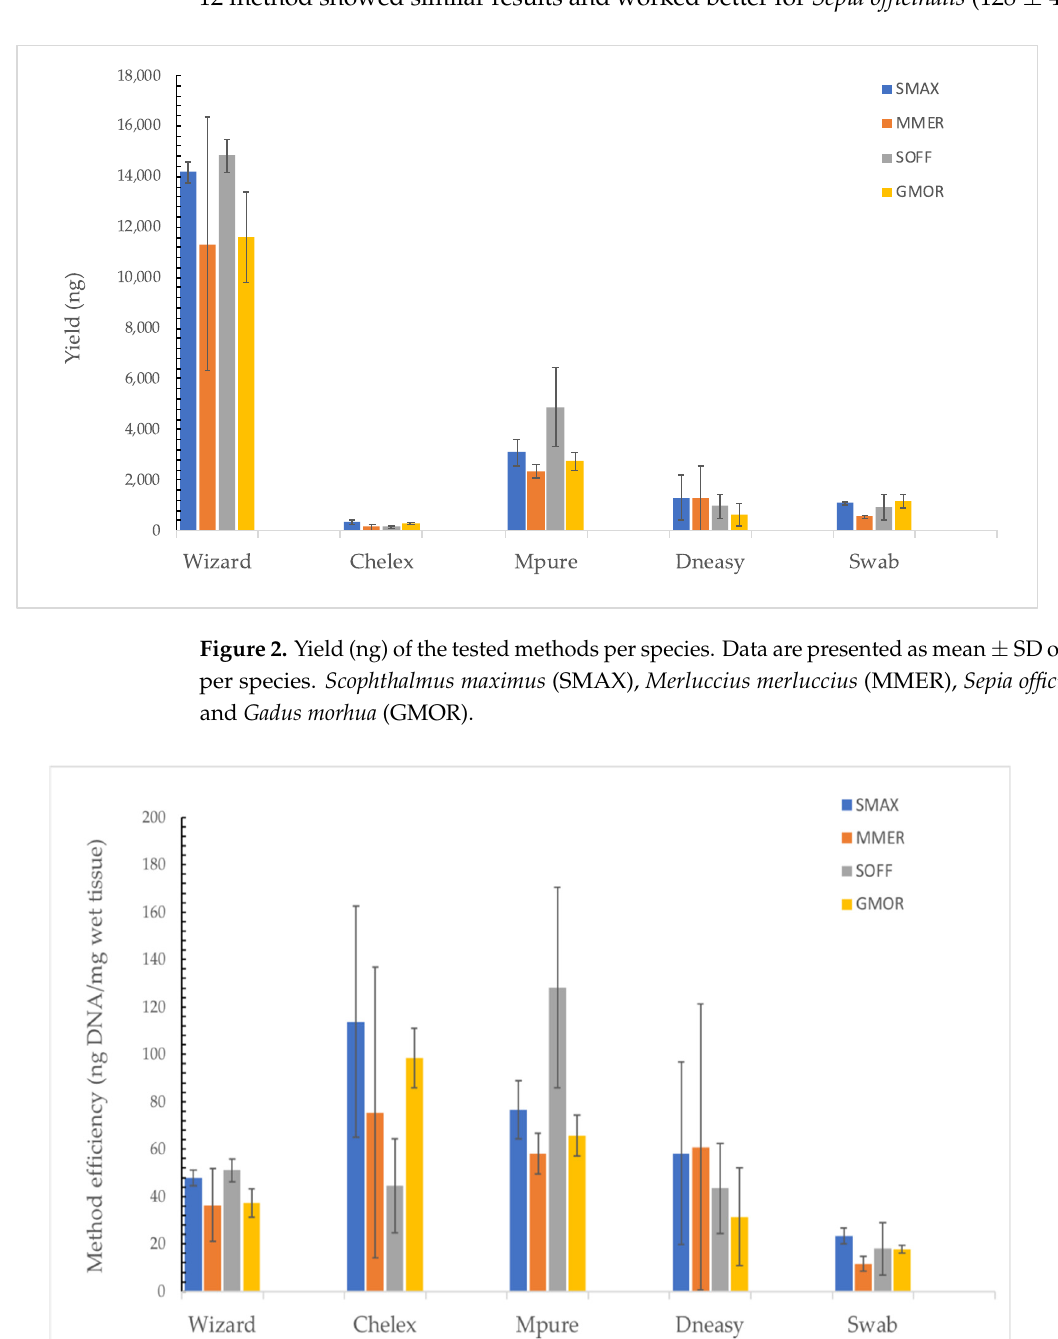
0.00.51.01.52.02.53.0